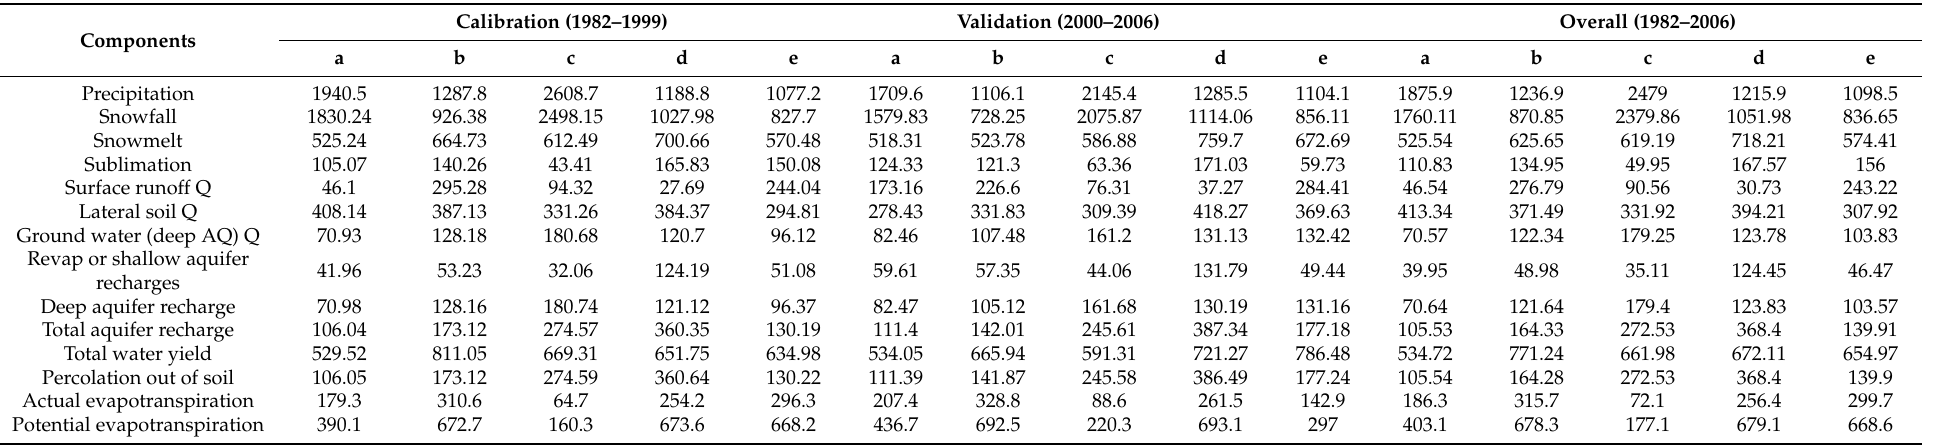
Table 4. The mean annual water balance components of the Upper Vakhsh River Basin in Central Asia during the calibration (1982–1999), validation (2000–2006) and overall (1982–2006) periods generated from the SWAT model. ( a ) Combination of the APHRODITE_V1101 and CFSR datasets; ( b ) combination of the APHRODITE_V1101 and CRU TS3.1 datasets; ( c )